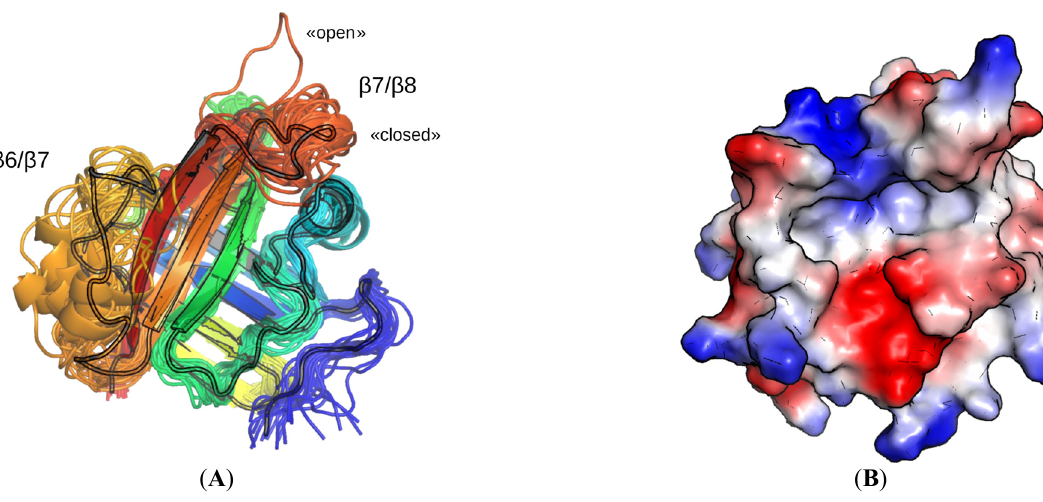
Figure 4. ( A ) Cartoon representation of the geometries of SrtA for each of the eight complexes and three replicas, overlayed onto the PDB:1T2W structure (shown outlined) using the function cealign of PyMol. ( B ) The simple electrostatic potential surface, generated for the PDB:1T2W structure in the same view as in the left